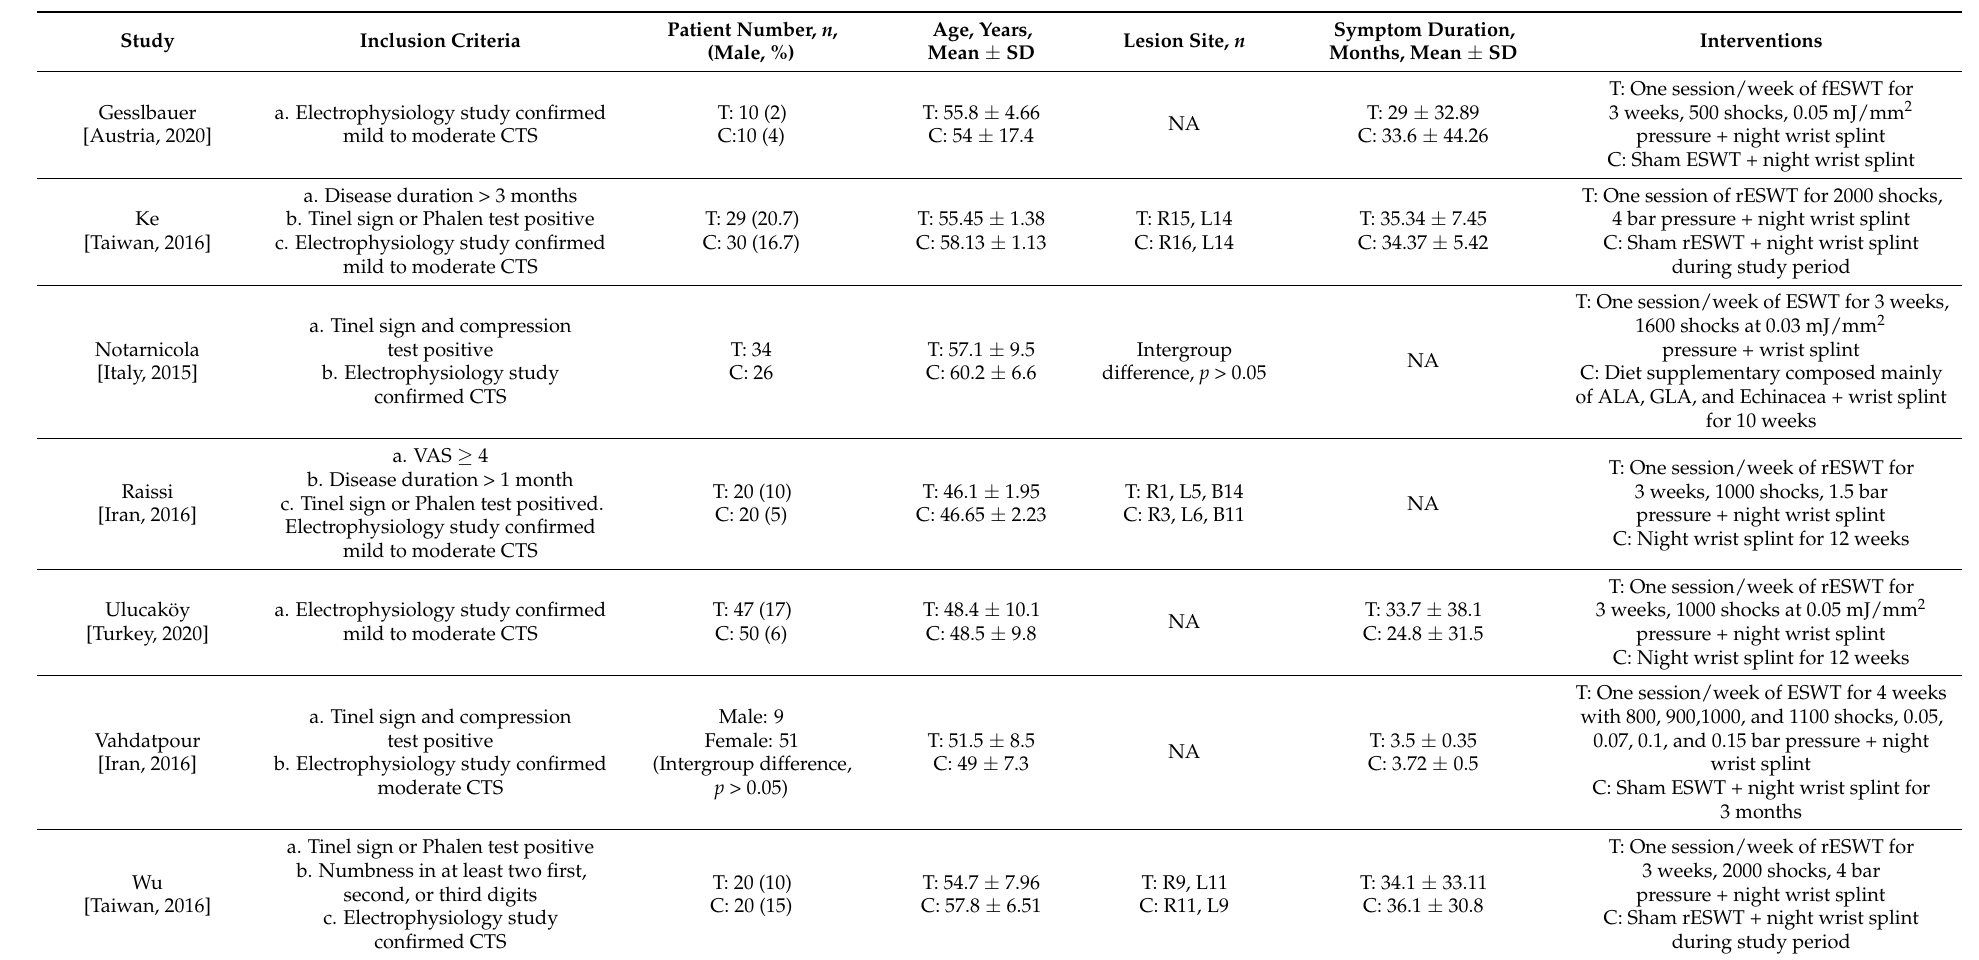
Table 1. Characteristics of the included